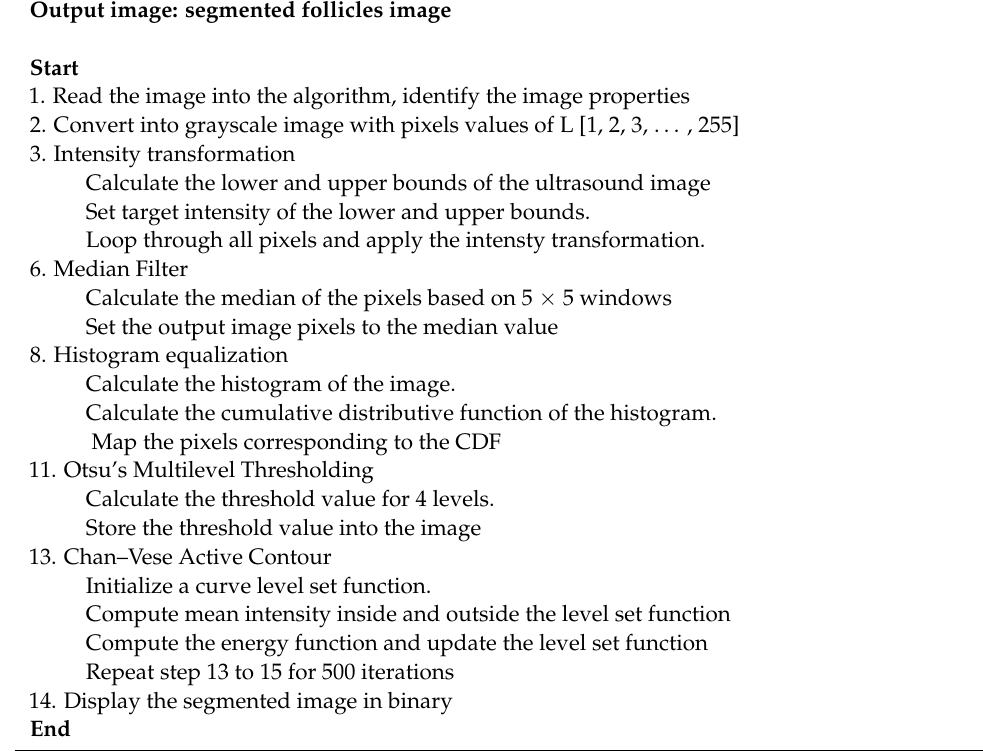
Algorithm 1 Otsu’s thresholding and Chan–Vese segmentation